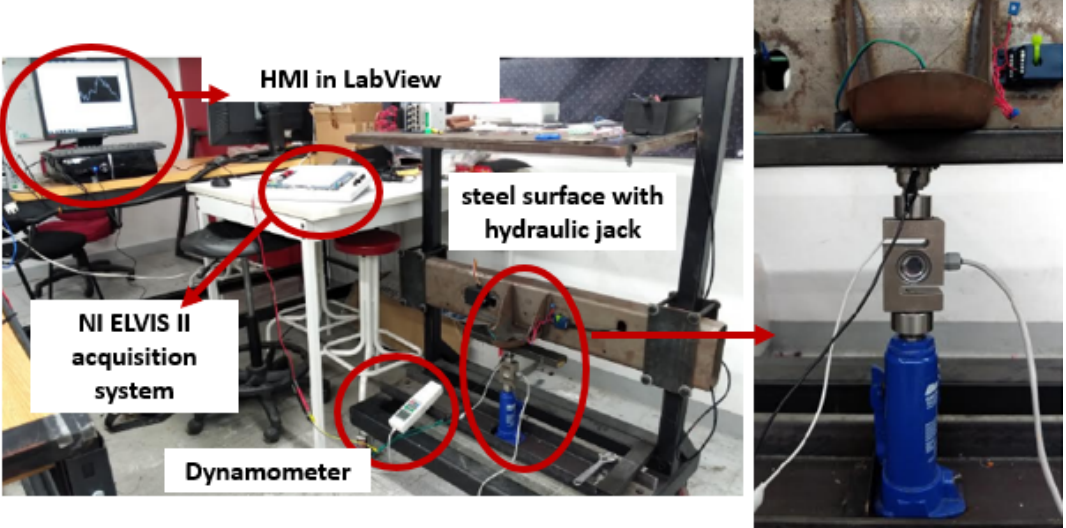
Figure 17. Laboratory setup for compression tests. Figures modified from